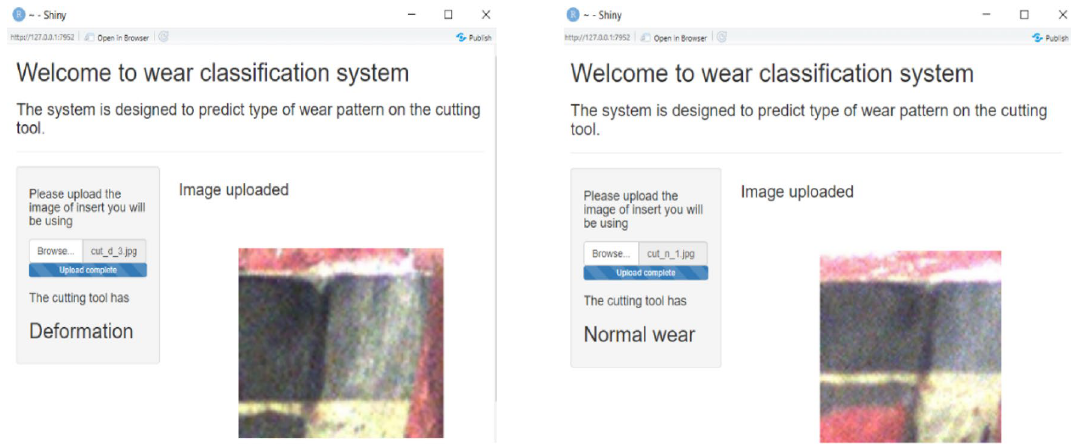
Fig. 7 GUI for the wear classification model